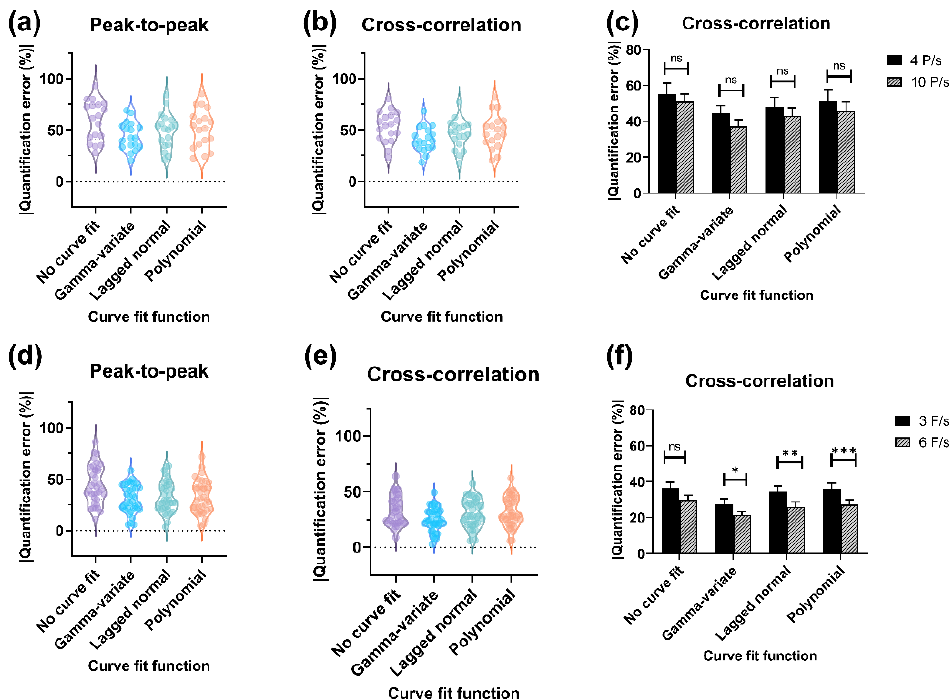
Figure 4. Evaluation of quantification error, Upper panel: Fluoroscopic imaging, Lower panel: DSA acquisition. Violin plots illustrating overall quantification error with PP and CC, algorithms for ( a , b ) fluoroscopic imaging, and ( d , e ) DSA acquisition. Bar graphs showing the absolute quantification error (mean ± SEM) with various curve-fitting models at different sampling rates for ( c ) fluoroscopic, and ( f ) DSA acquisition. The shape of the violin plot indicates overall sample distribution, and the central region specifies the median and interquartile range. ns—non-significant, *—0.044, **—0.013, ***—0.022.